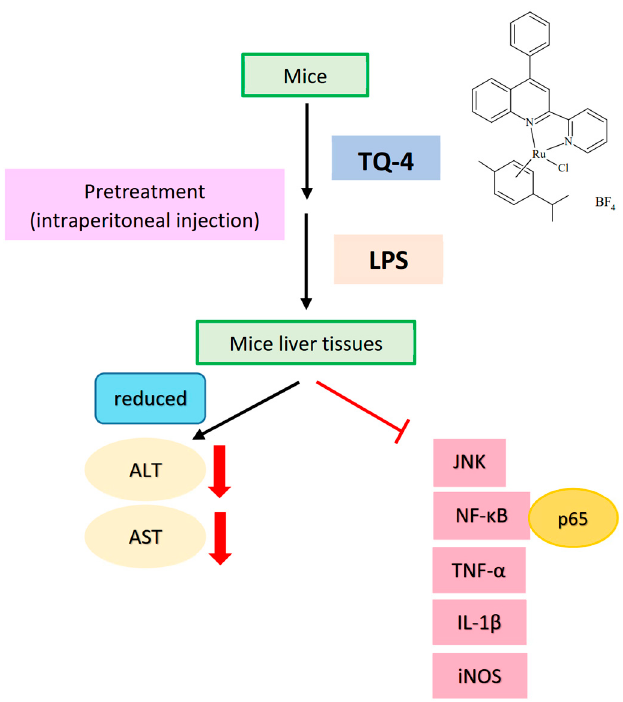
Figure 4. In vivo anti-inflammatory mechanism of TQ-4: TQ-4 effectively reduced LPS-induced serum alanine transaminase (ALT), aspartate transaminase (AST), TNF- α , IL-1 β , iNOS, NF- κ B p65 and JNK phosphorylation in LPS-induced mice liver tissues.